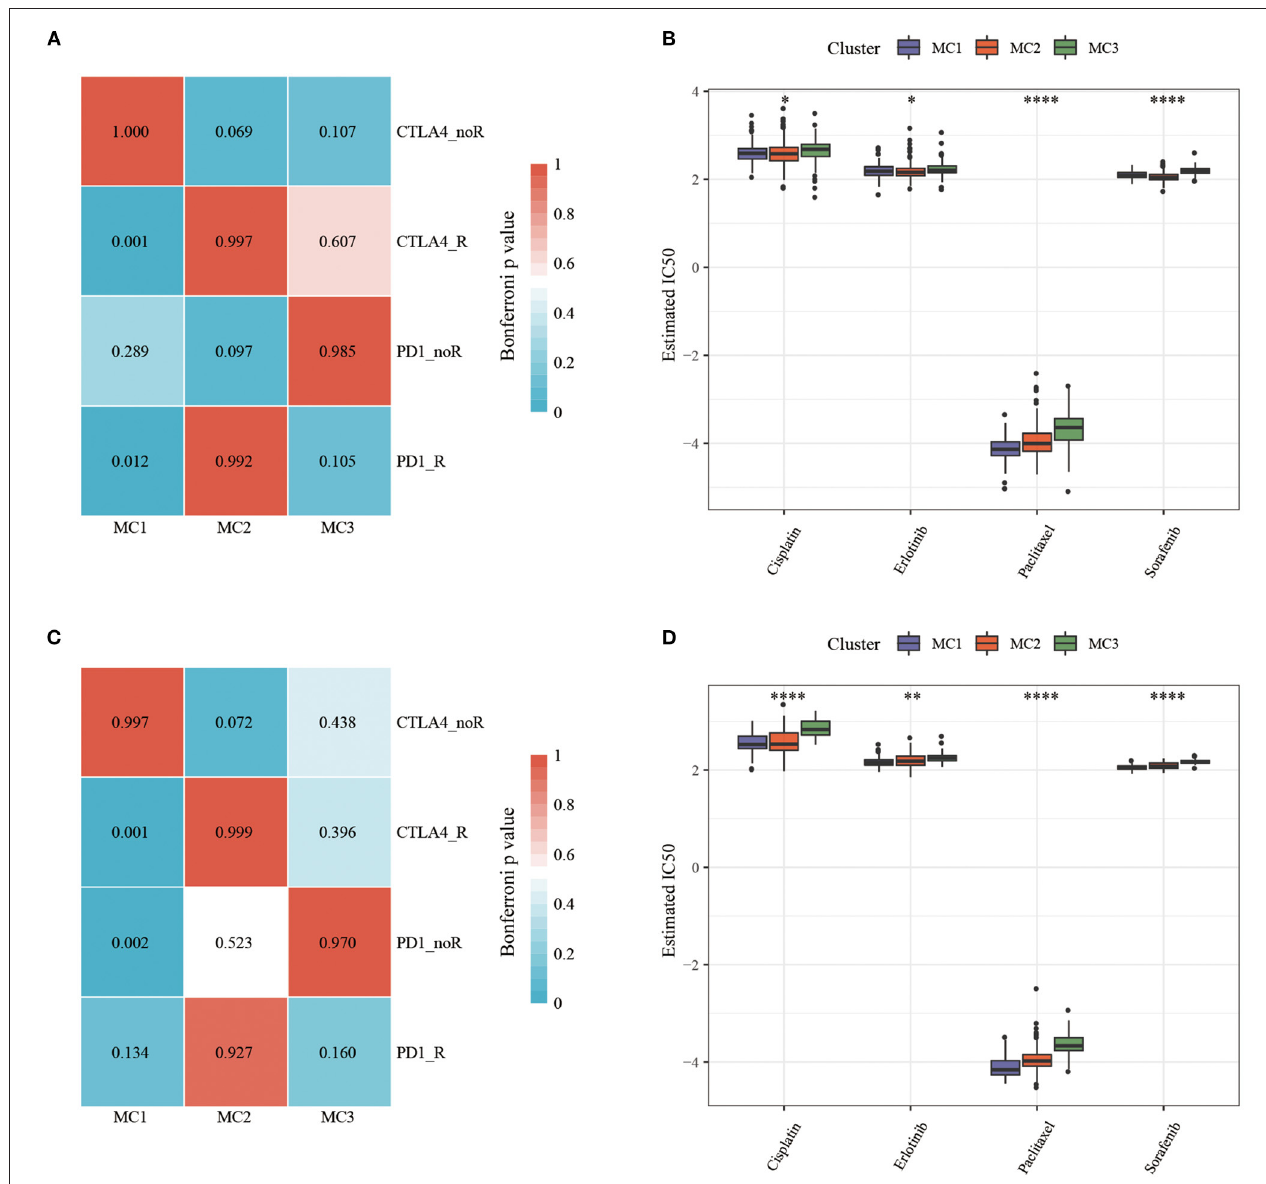
FIGURE 7 | (A) RNASeq, Submap analysis manifested that MC1 could be more sensitive to CTLA4 (Bonferroni-corrected P < 0.05); (B) RNASeq, The box plots of the estimated IC50; (C) GSE, Submap analysis manifested that MC1 could be more sensitive to CTLA4 (Bonferroni-corrected P < 0.05); (D) GSE, The box plots of the estimated IC50. * P < 0.05, ** P < 0.01, **** P <